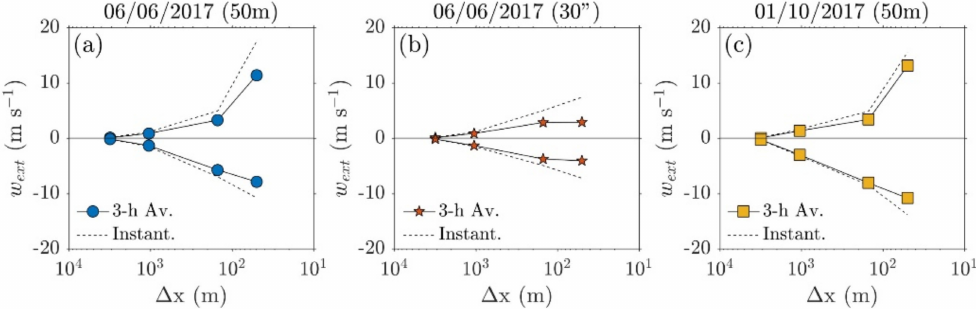
Figure 12. Vertical velocity extrema (minimum and maximum values) on the volcano lee–side against horizontal grid spacing for the: ( a ) June (50 m), ( b ) June (30”), and ( c ) October (50 m) simulations. Data shown based on 3–h averages (solid lines) and instantaneous values (dashed